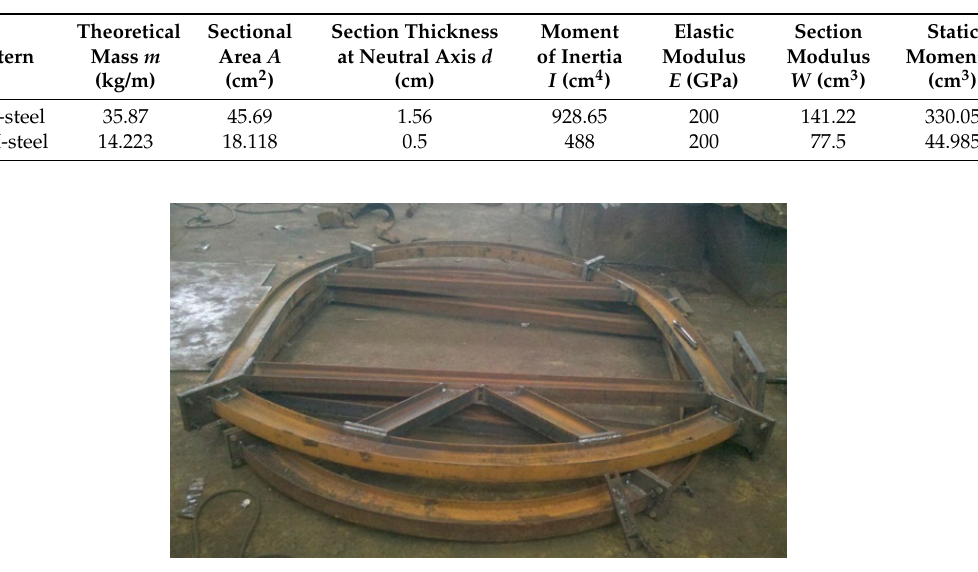
Table 1. Parameters of 36 U-steel and 12.6 I-steel.